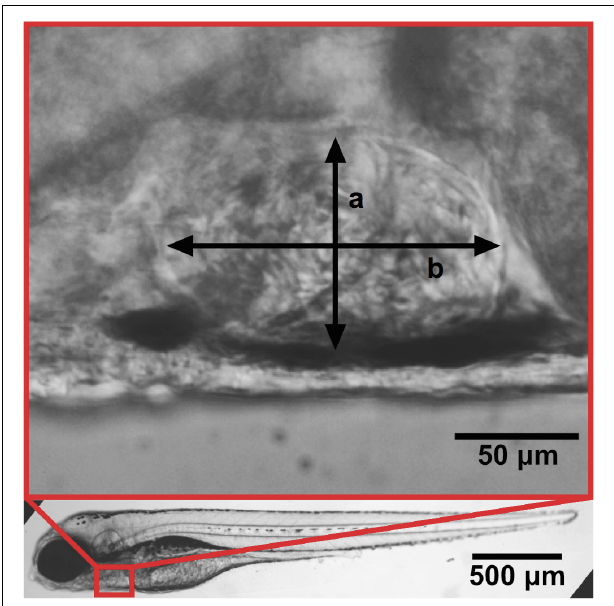
FIGURE 1 | Zebrafish at 4 dpf with a zoom-in of the ventricle. Ventricular width a and length b. Adapted with permission from Paavola et al. (2020).